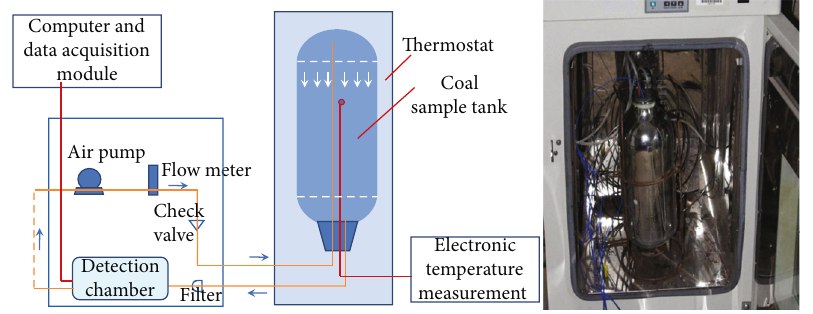
Figure 3: Schematic of closed oxygen consumption experimental device.